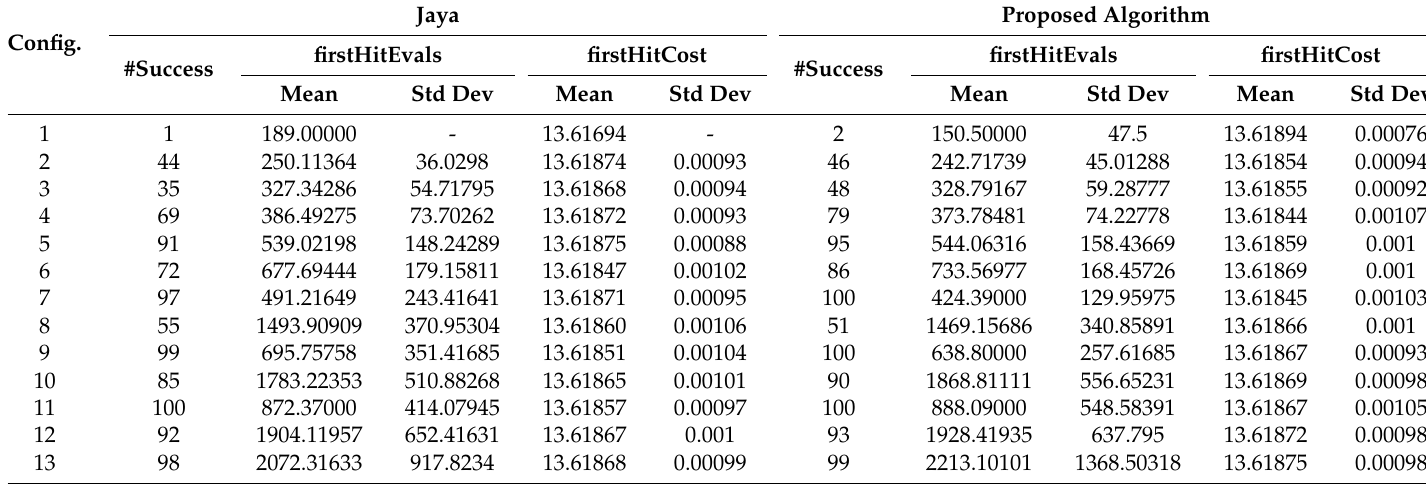
Table 15. Comparison between Jaya and the proposed method on firstHitEvals and firstHitCost (each row corresponds to 100 independent runs). Current step size = 1 mA, target cost =